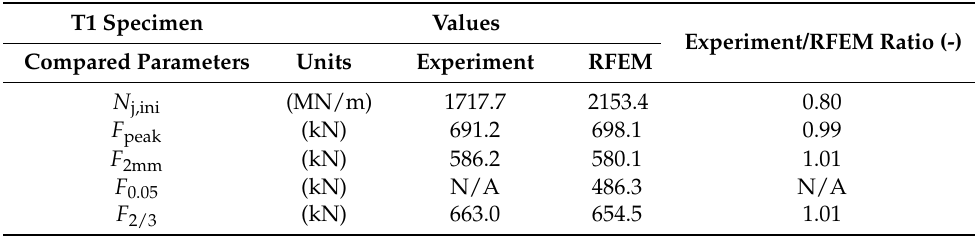
Table 2. Results of validation, T1.